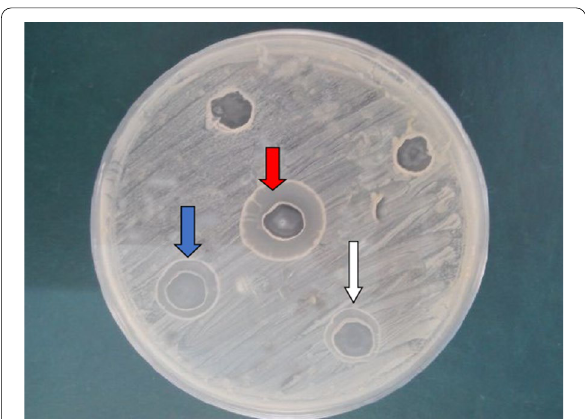
Fig. 7 Antagonistic effect of Metschnikowia pulcherrima (white arrow), Saccharomyces cerevisiae 001 (red arrow) & 003 (blue arrow) against Vibrio cholerae